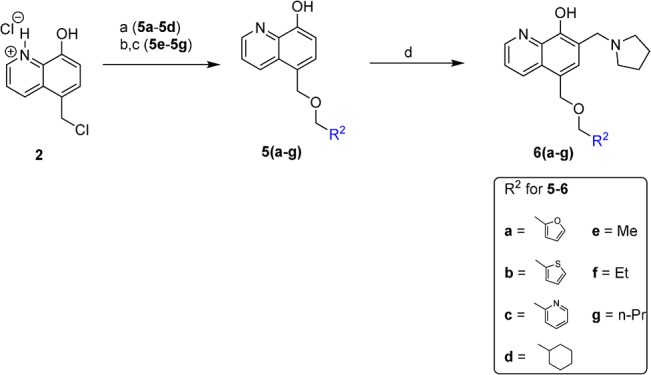
Synthesis of compounds 6a-6g.Reagents and conditions: (a) R2CH2OH, NaH, THF, reflux; (b) R2CH2OH, 110 oC; (c) NH4OH, H2O, Et2O, pH 8–10; (d) paraformaldehyde, pyrrolidine,EtOH, reflux.